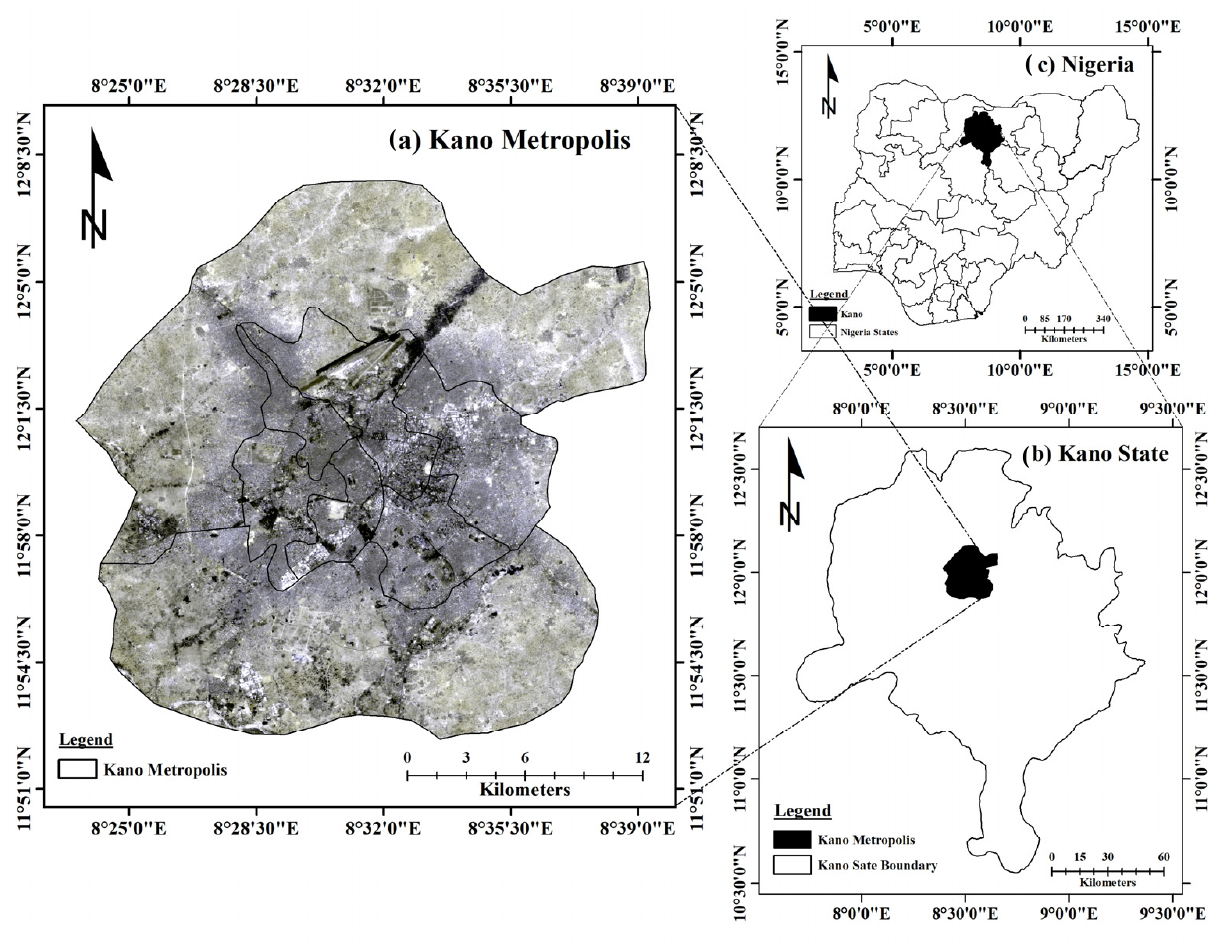
Figure 1. Location map of the study area, i.e., ( a ) Kano metropolis in, ( b ) Kano State, and ( c ) Nigeria. Table 1. Urban population growth of Kano